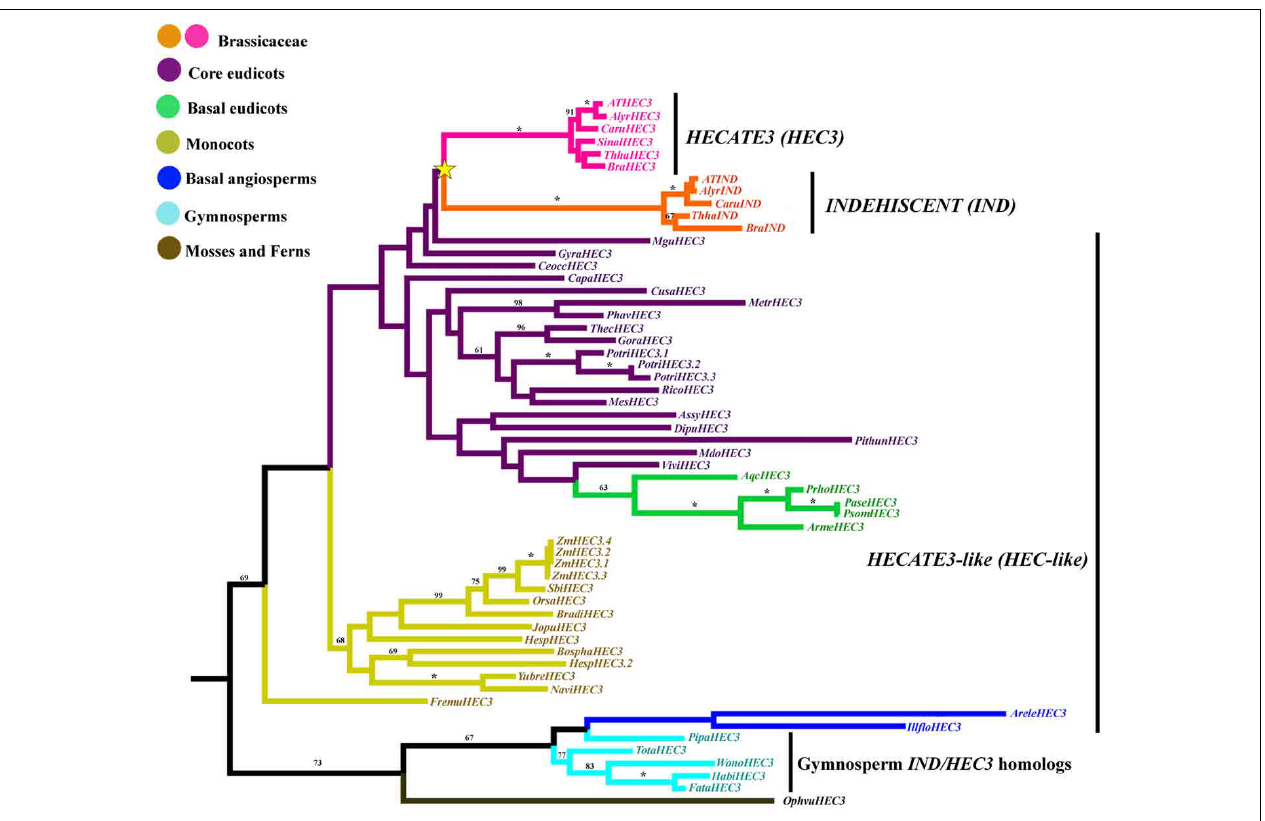
FIGURE 9 | ML tree of INDEHISCENT/HECATE3 genes in seed plants showing a duplication in Brassicaceae (yellow star). This duplication resulted in the INDEHISCENT Brassicaceae specific genes from a HECATE3-like ancestral single copy in most core and basal